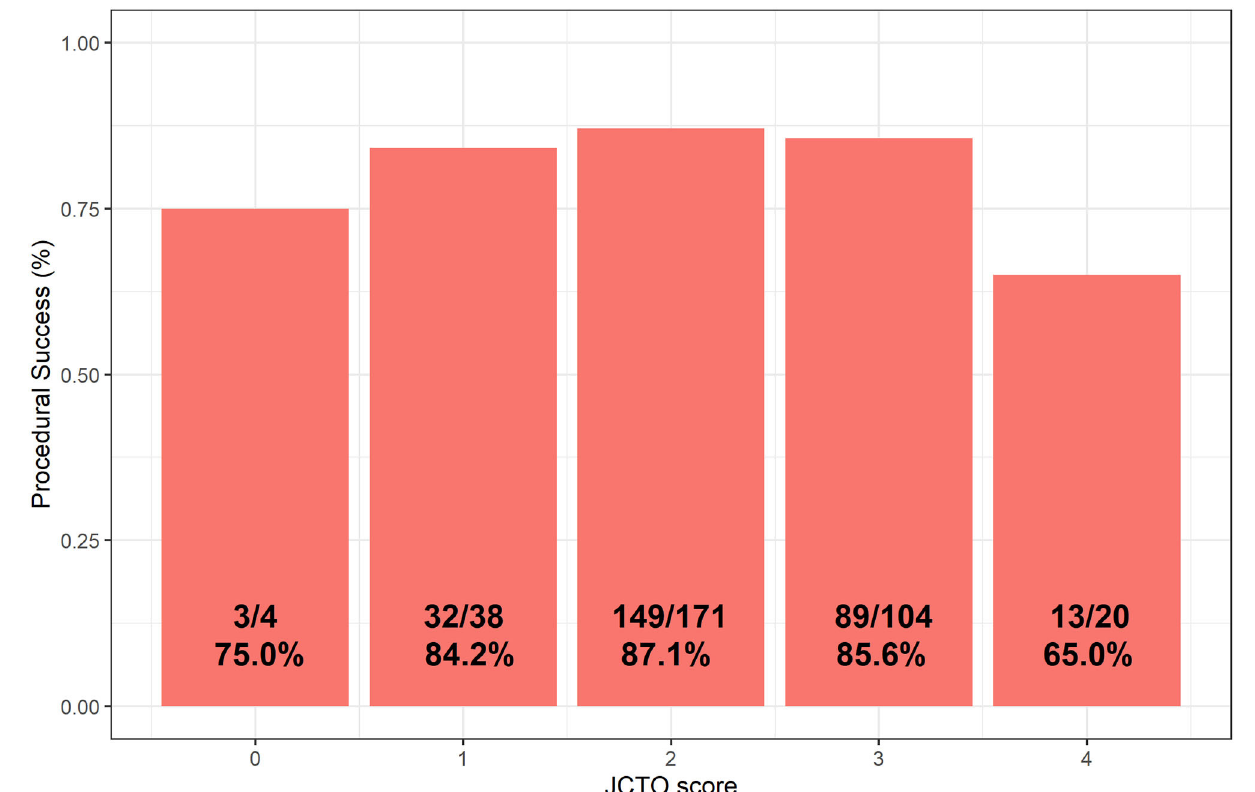
Frontiers in Cardiovascular Medicine |